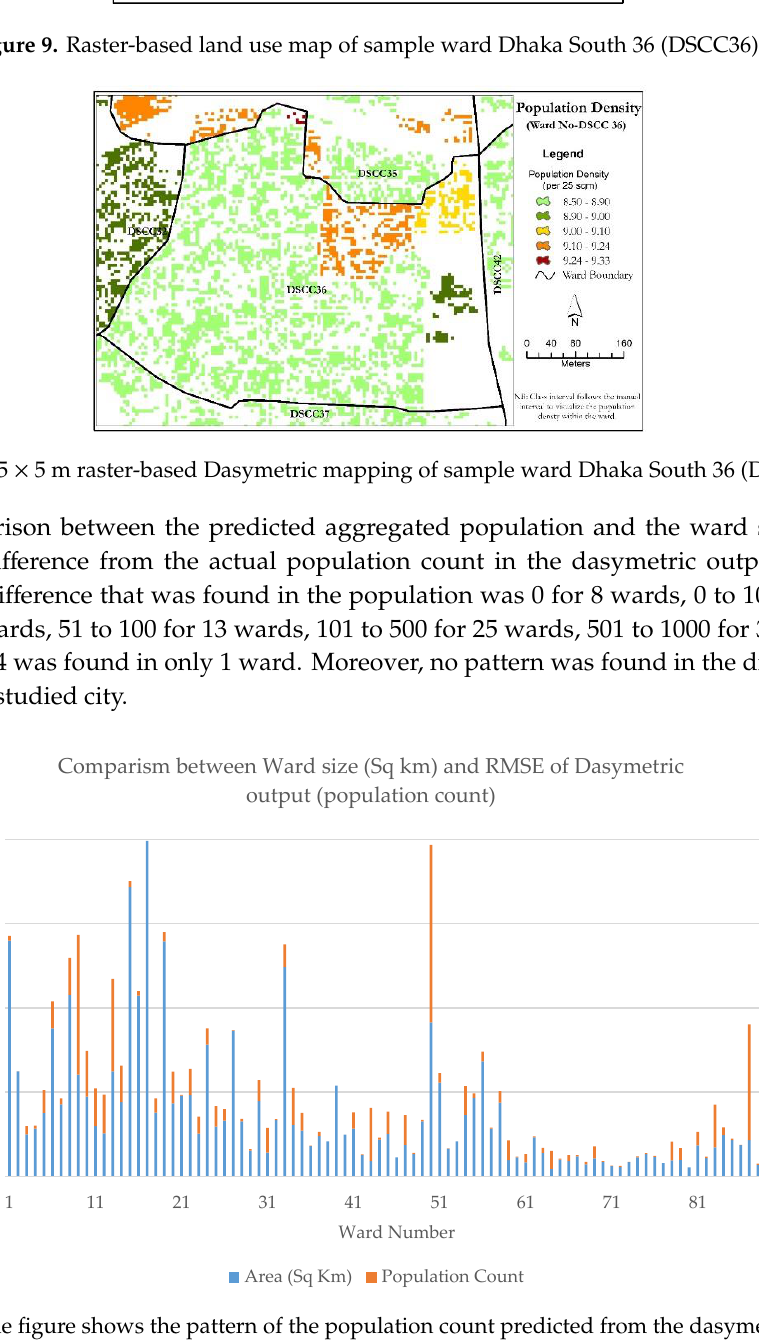
Figure 7. Output of the 5x5 m raster-based dasymetric mapping of the study area. Figure 8. Output of the choropleth map of the study area. Figure 9. Raster-based land use map of sample ward Dhaka South 36 (DSCC36). Figure 9. Raster-based land use map of sample ward Dhaka South 36 (DSCC36).